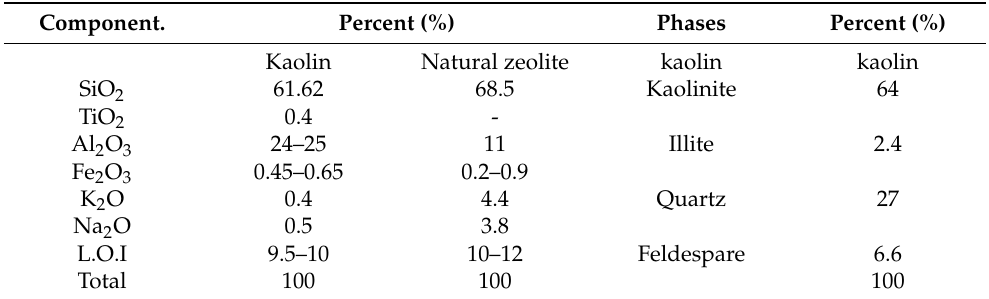
Table 2. Analyses of the chemical composition of kaolin clay and natural zeolite used to fabricate ceramic membranes.